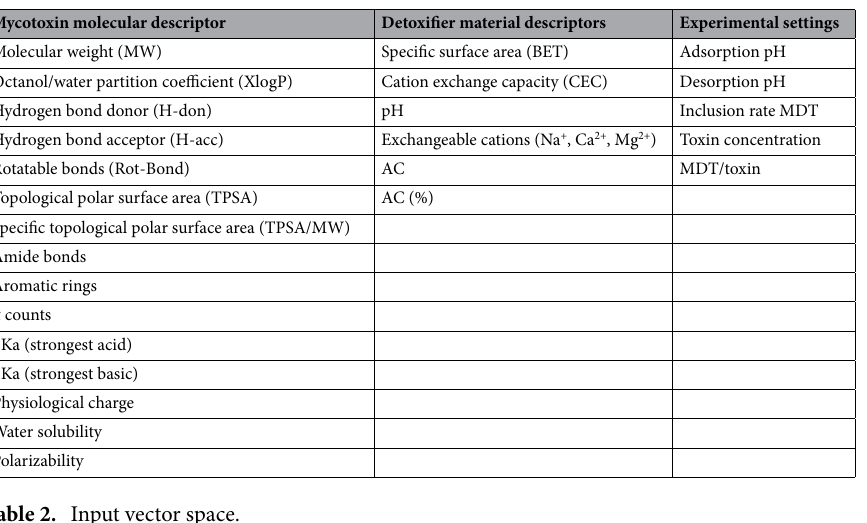
and Table S4. The models’ codes are available in zenodo repository with the identifier https:// doi. org/ 10. 5281/ zenodo. 57939 56. Capturing synergy.